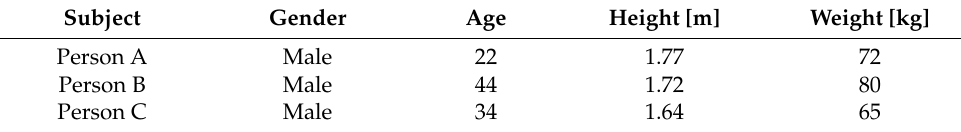
Table 6. Test subject’s physiology information.